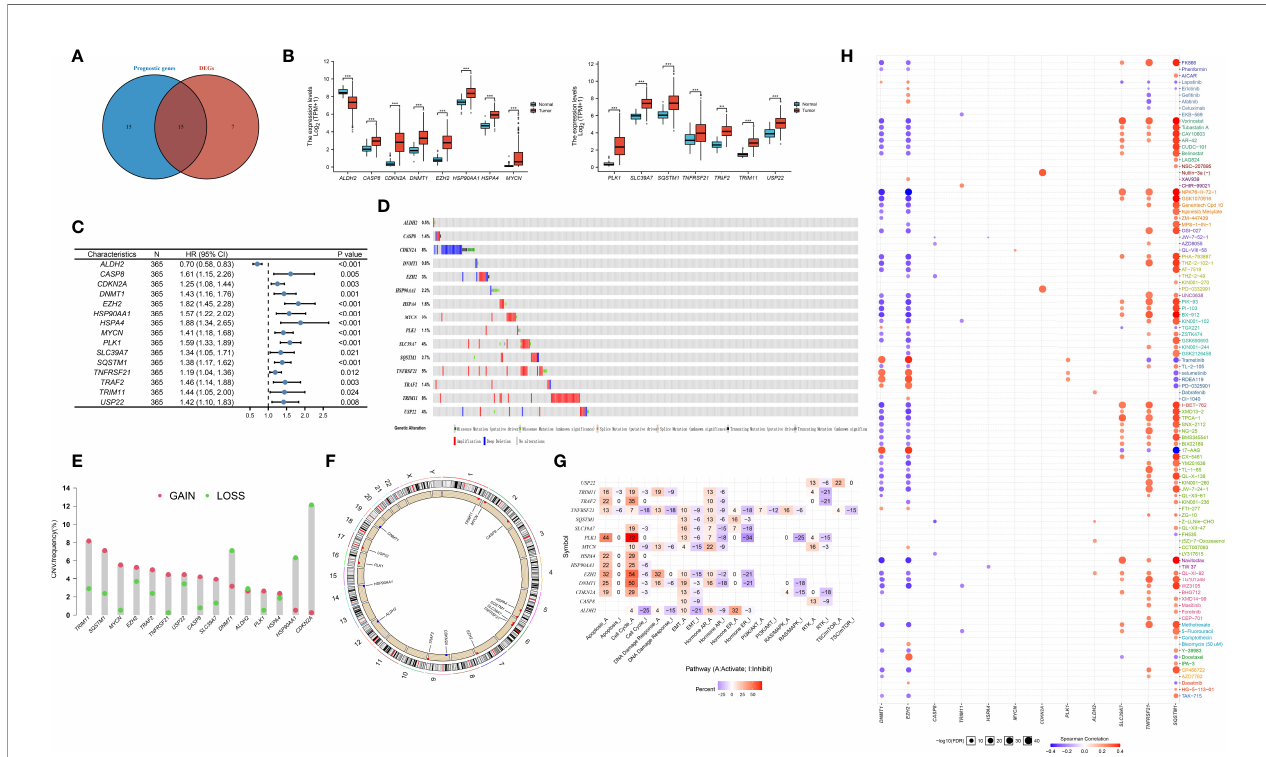
FIGURE 2 | De fi ning of the expression, prognostic, and genetic mutation landscape of necroptosis related genes in TCGA-LIHC cohort. (A) Venn diagram shown 15 differentially expressed necroptosis related genes that were correlated with OS. (B) The illustration shown the expression of 15 differentially expressed necroptosis related genes between paired normal (blue) and HCC (red) tissues (Student ’ s t test). The asterisks represented the statistical p-value (*P < 0.05; **P < 0.01; ***P < 0.001). (C) Forest plots shown the results of the univariate Cox regression between 15 differentially expressed necroptosis related genes and overall survival in HCC. (D) The mutation frequency of 15 necroptosis related genes in 365 patients with HCC from TCGA-LIHC cohort. Each column represented individual patients. The number on the left indicated the mutation frequency in each gene. (E) The CNV variation frequency of 15 necroptosis related genes in TCGA-LIHC cohort. The height of the column represented the alteration frequency. The blue dot represent loss frequency; The red dot represent gain frequency. (F) The location of CNV alteration of 15 necroptosis related genes on 23 chromosomes using TCGA-LIHC cohort. (G) The illustration shown the relationship between cancer related pathways and 15 necroptosis related genes. (H) The illustration shown the relationship between drug sensitivity and 15 necroptosis related genes in GDSC